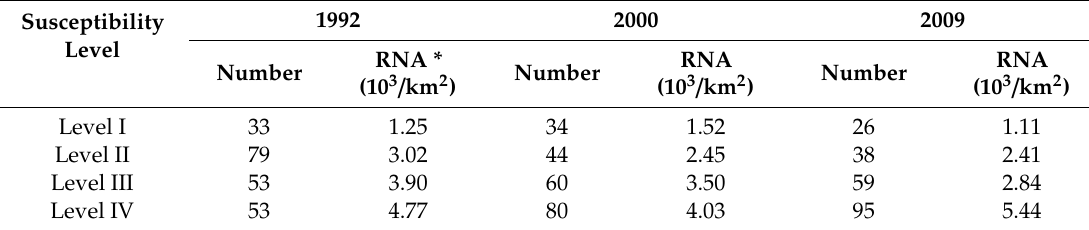
Table 5. Historical landslide event levels.